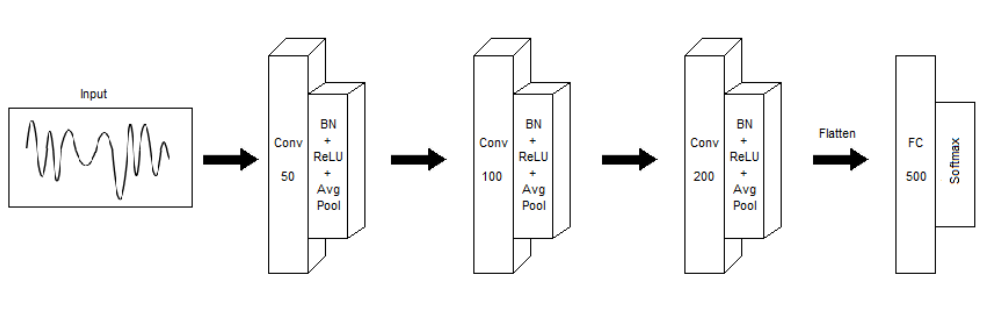
Figure 1. Architecture used for the Convolutional Neural Network (CNN). BN stands for Batch Normalization, ReLU for Rectified Linear Unit, and FC for fully